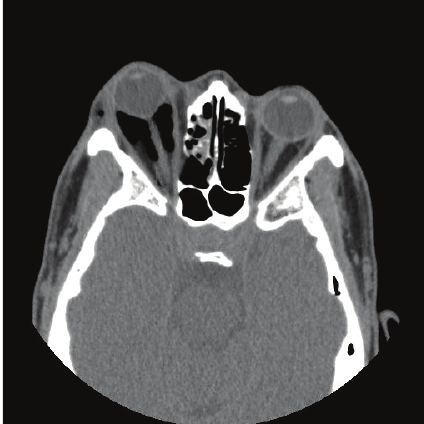
Figure 1: Diffuse intraconal/preseptal air and severe proptosis of the right eye resulting in tenting of the optic globe and stretching of the optic nerve.